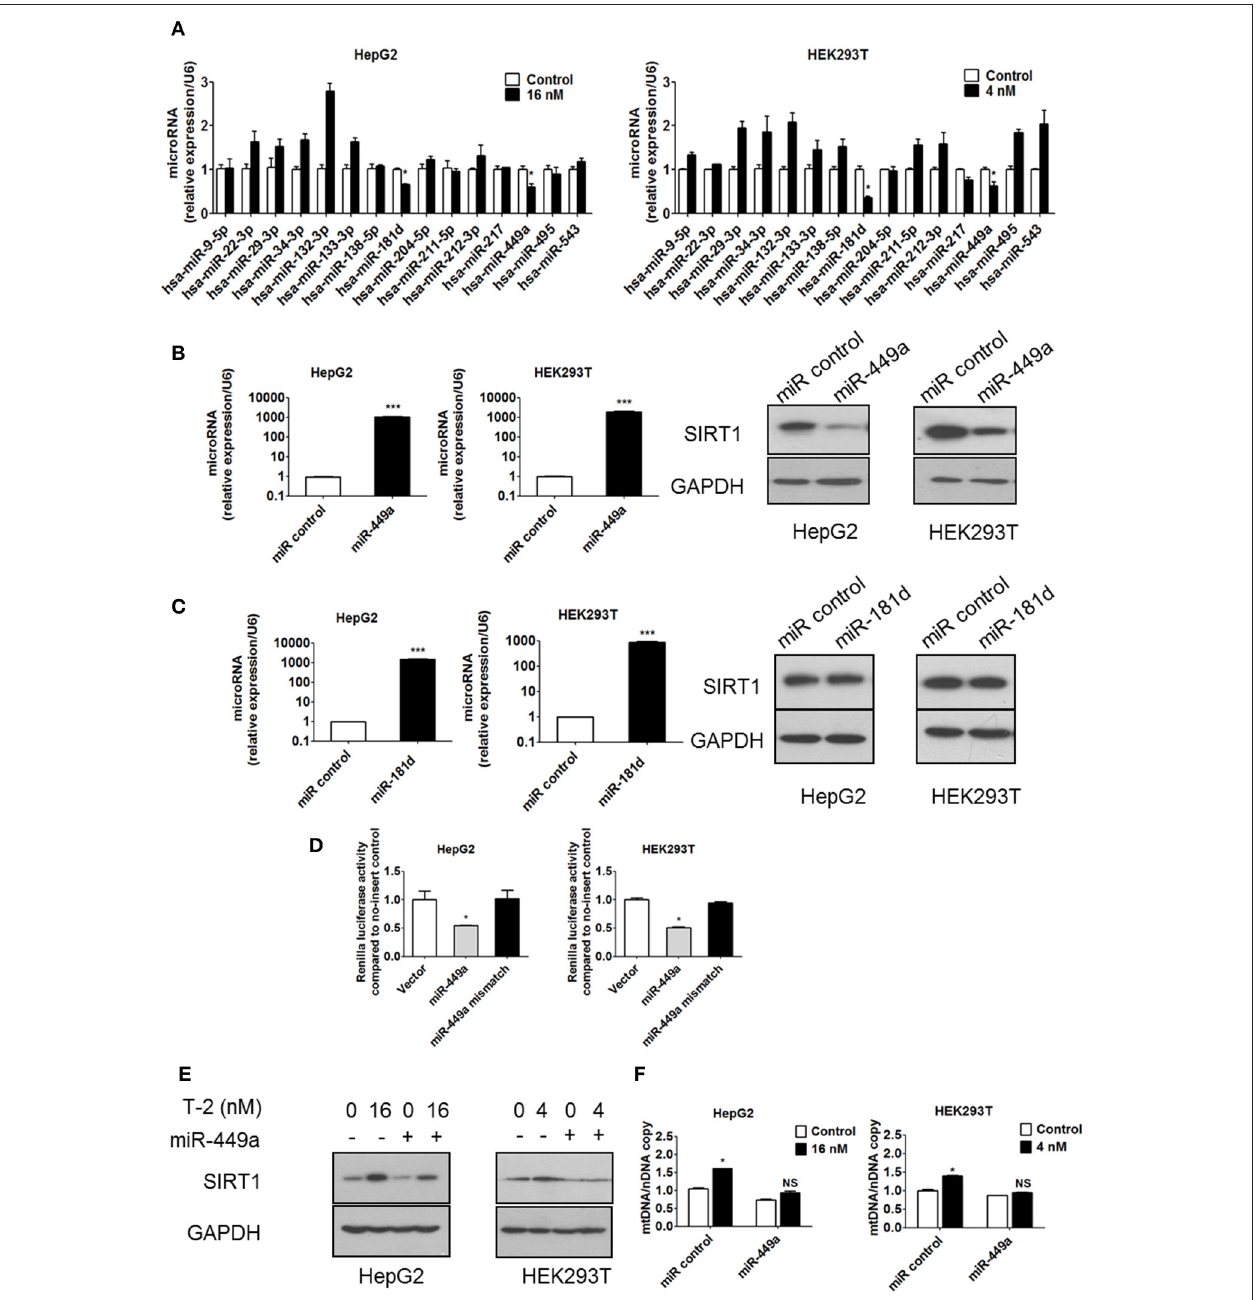
FIGURE 6 | T-2 toxin enhances protein level of SIRT1 through miR-449a. (A) miRNA expression in T-2 toxin-treated cells. Top, miRNA levels in HepG2 cells analyzed by RT-qPCR; Bottom, miRNA levels in HEK293T cells analyzed by RT-qPCR. (B) The expression levels of miR-449a in HepG2 and HEK293T cells transfected with miR-449a mimics was detected by RT-qPCR. The protein level of SIRT1 in HepG2 and HEK293T cells transfected with miR-449a mimics was analyzed. Left, SIRT1 protein level in HepG2 cells; right, SIRT1 protein level in HEK293T cells. (C) The expression level of miR-181d in HepG2 and HEK293T cells transfected with miR-181d mimics was detected by RT-qPCR. The SIRT1 expression level in HepG2 and HEK293T cells transfected with miR-181d mimics was analyzed by western blotting. Left, SIRT1 protein level in HepG2 cells; Right, SIRT1 protein level in HEK293T cells. (D) Luciferase reporter assays were performed in HepG2 and HEK293T cells transfected with either the control pmirGLO vector or pmirGLO containing the SIRT1 3 ′ UTR target sequence of miR-449a (both wild type and mutant), in the presence of miR-449a mimics. (E) The protein level of SIRT1 in HepG2 and HEK293T cells transfected with miR-449a mimics and treated with T-2 toxin was analyzed. (F) The mitochondrial DNA content in HepG2 and HEK293T cells transfected with miR-449a mimics and treated with T-2 toxin was analyzed. Statistically significant differences are indicated by asterisks (* P < 0.05, *** P < 0.001).